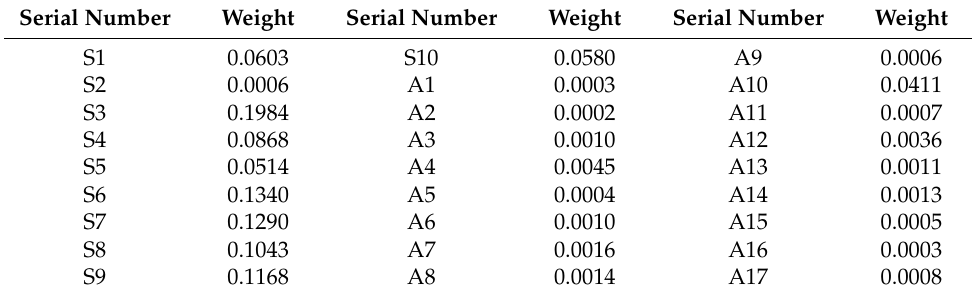
Table 2. The Weight of each